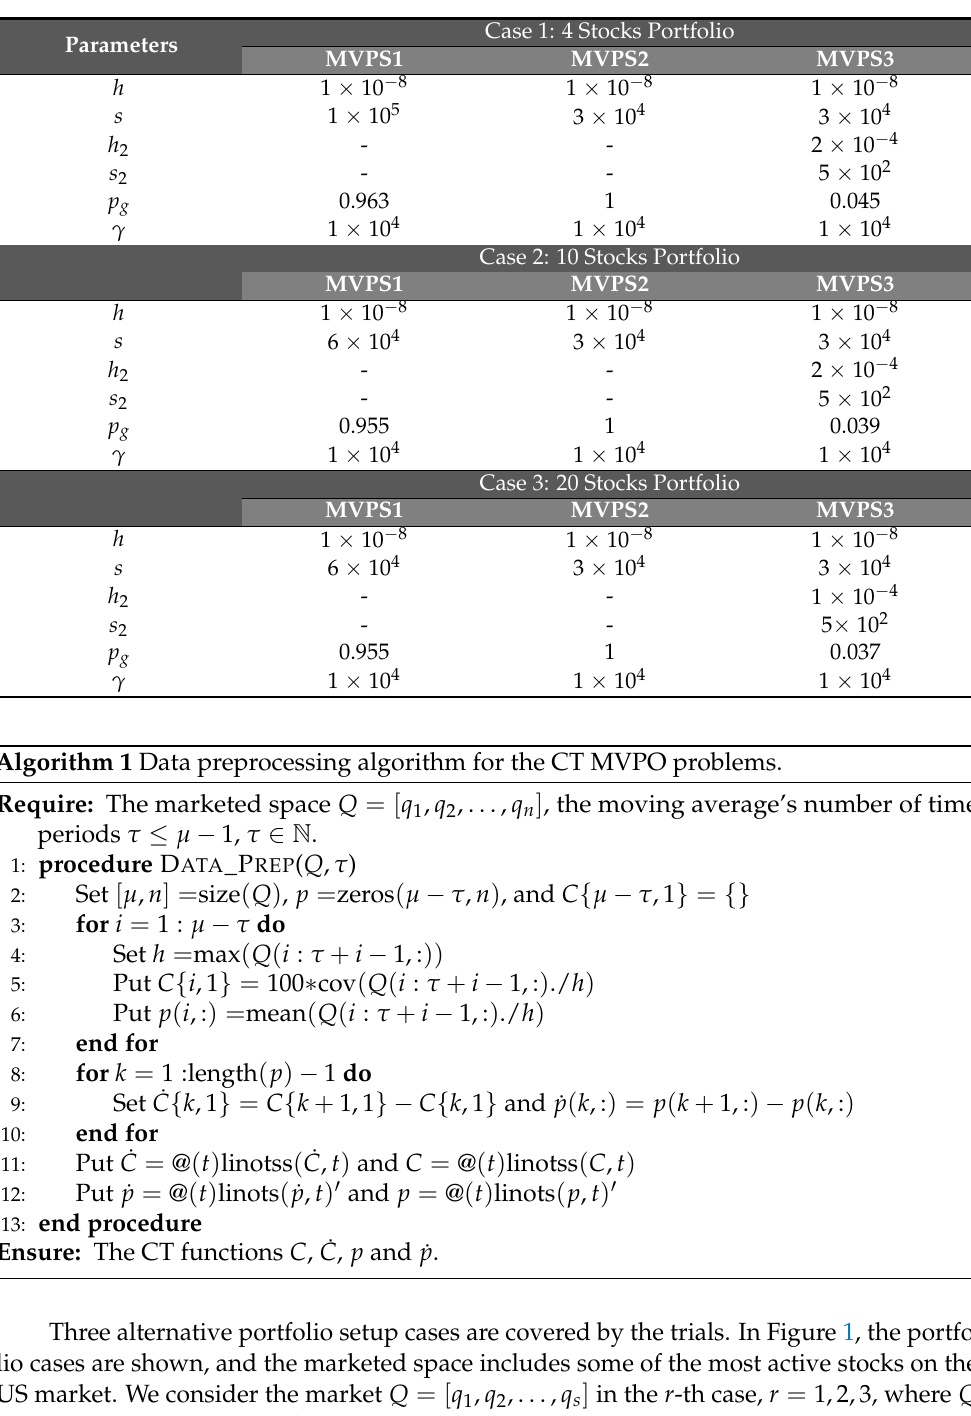
Table 1. The ZNN parameters for solving the CT MVPO problems.